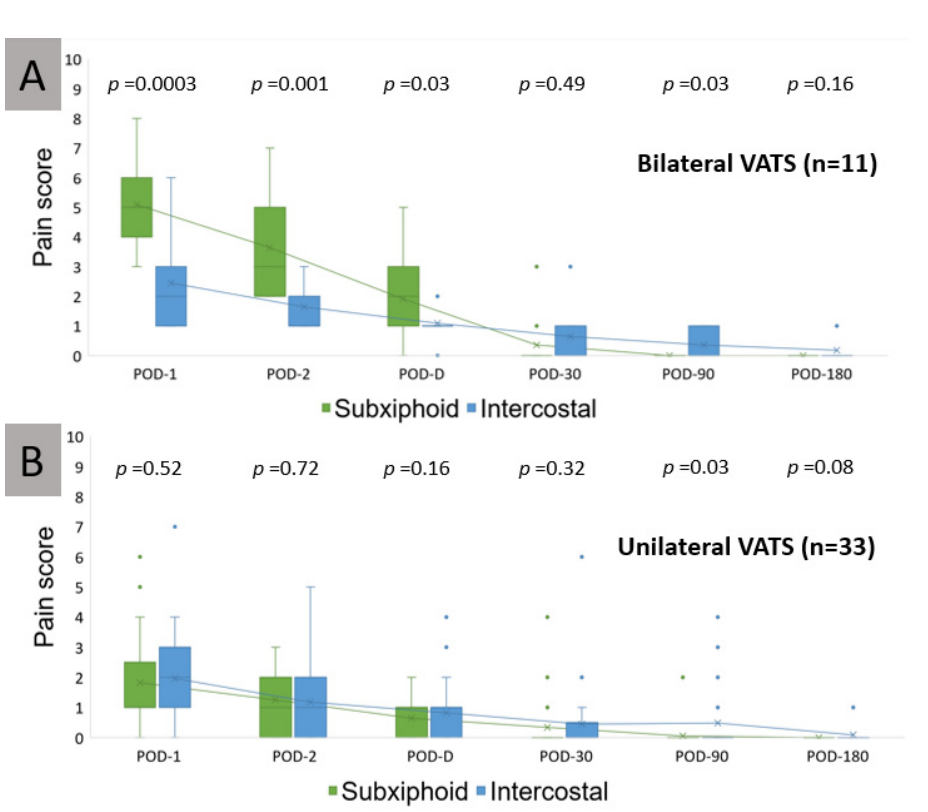
Figure 7. Box and whisker plots showing pain scores for the subgroups of patients. Box plots show- ing pain scores for subxiphoid and intercostal incisions in the same patient receiving bilateral uniportal VATS ( A ) and unilateral multiportal VATS ( B ). Arrowhead, equal length subxiphoid and intercostal incisions. VATS, video-assisted thoracoscopic surgery. Subxiphoid incision represented in green, intercostal in blue. POD, postoperative day. D, discharge.